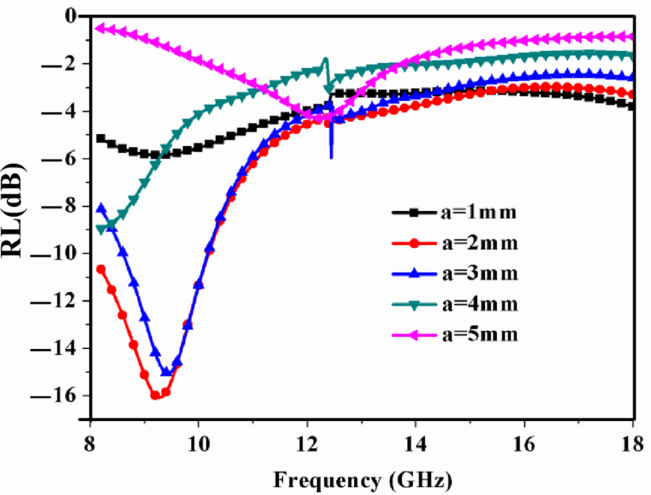
Figure 6. Simulated reflection loss of the RAM versus frequency for different a . C = 10 mm, t = 2